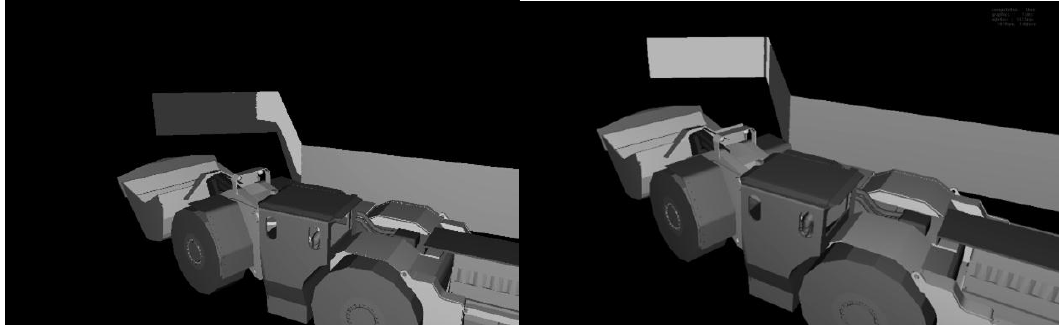
Figure 6. LHD in a 60° drift articulated 19.3° with operator line of sight ( left ) and maximum camera visibility ( right ) on planes 1 and 2 (light area = LOS, dark area = no LOS).